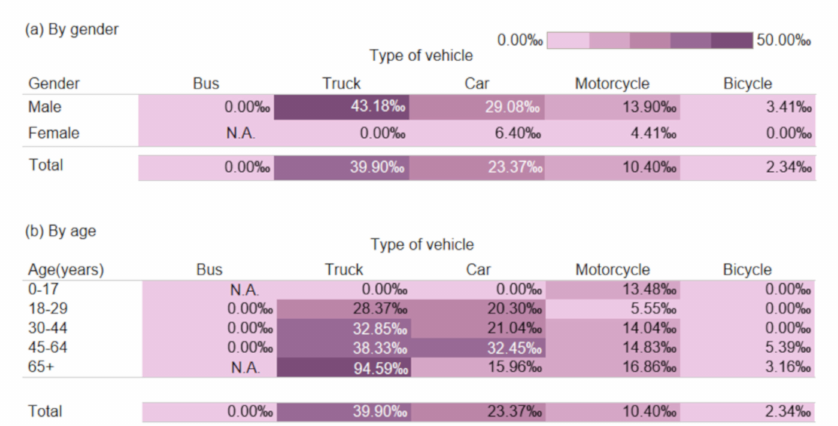
Figure 2. Prevalence (per 100) of injury among driver victims involved in single-vehicle crashes according to type of vehicle ( a ) by gender and ( b ) by age.